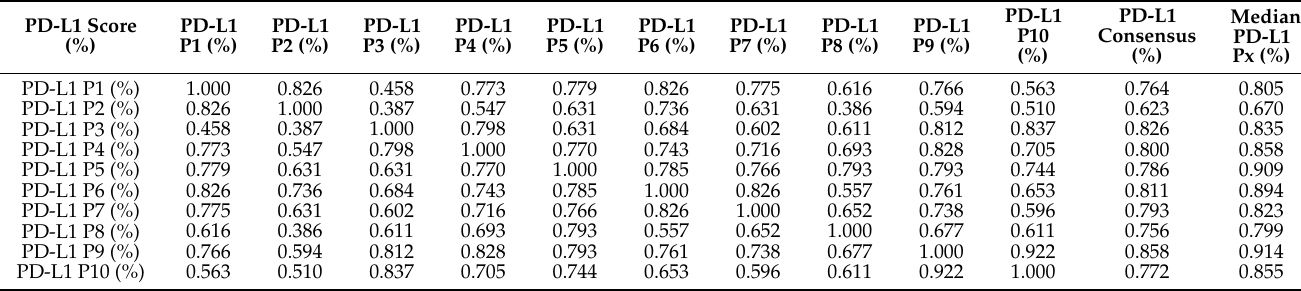
Table 1. Intraclass correlation coefficients for PD-L1/SP142 assessment as percentages in the proficiency set, as evaluated by ten participating pathologists.